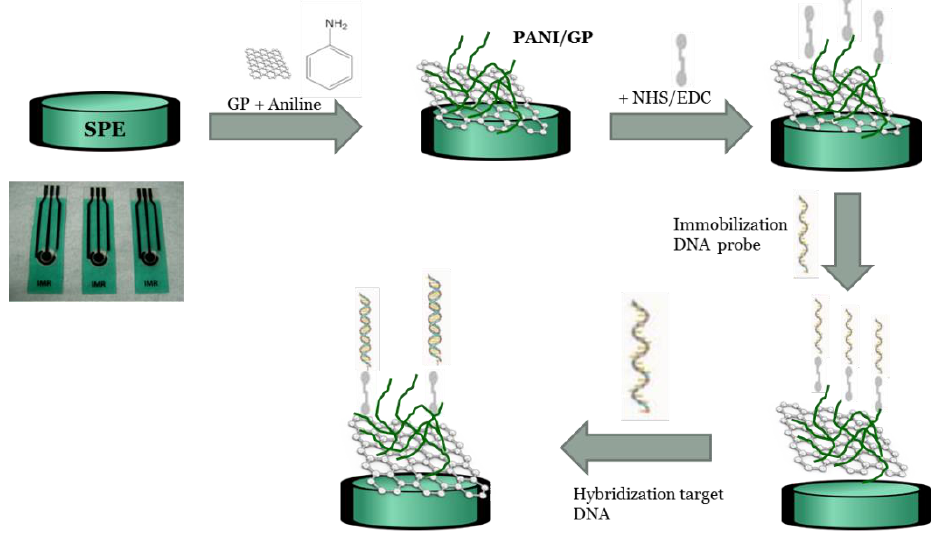
Figure 1. Schematic illustration of the stepwise electrochemical fabrication process for DNA biosensor.